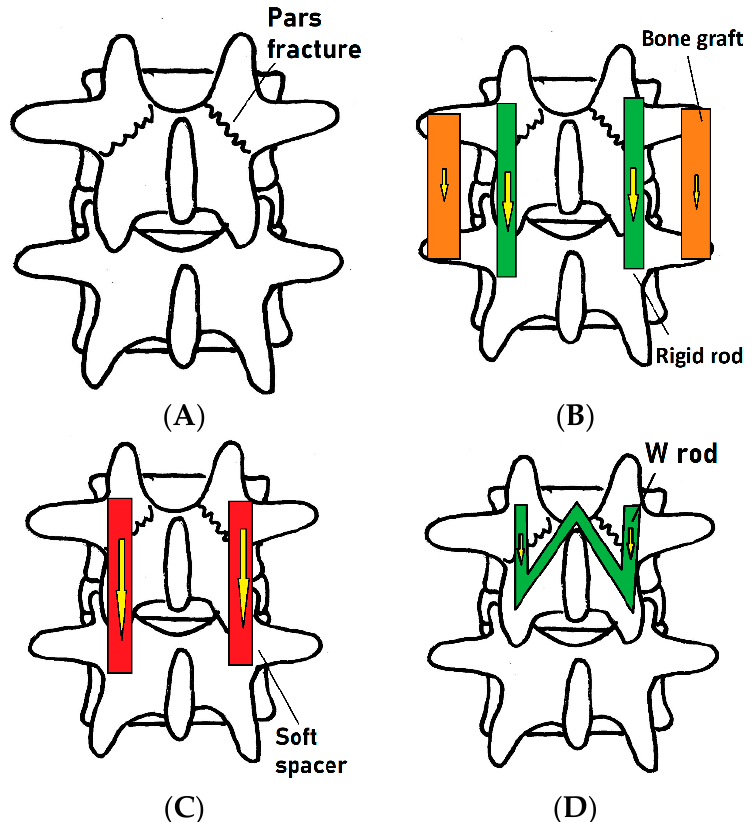
Figure 8. Force flow (arrow indicated) of spinal motion segment in four FE models: ( A ) Bipars, ( B ) Bipars_PLF, ( C ) Bipars_Dyn, ( D )